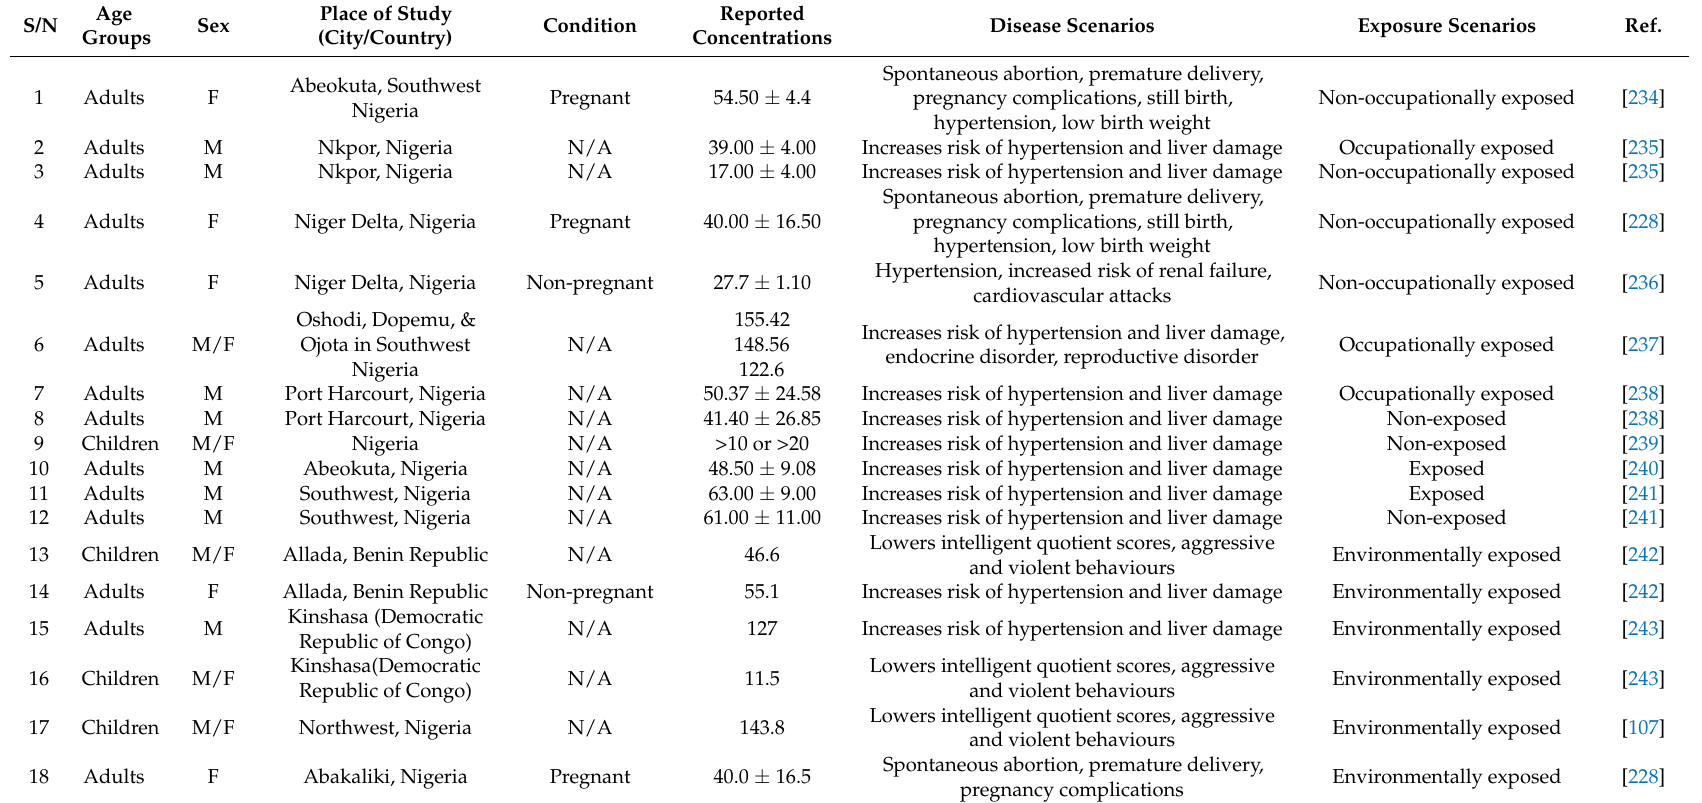
Table 2. Blood lead levels (ug/dL) and public health effects in Sub-Saharan